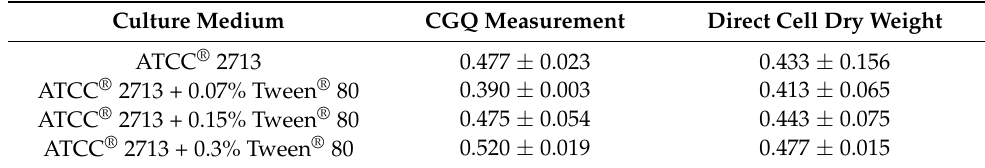
Table 2. Clostridium carboxidivorans cell concentration (g dry weight of cells/L) after 120 h of syngas fermentation obtained by CGQ measurement and calculated by direct cell dry weight measurement for different